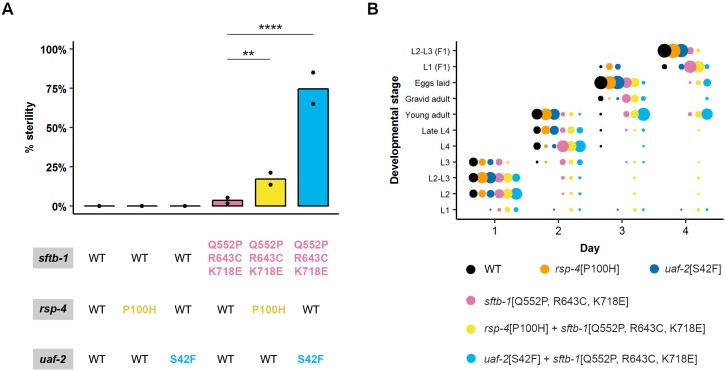
Genetic interaction between rsp-4/SRSF2, uaf-2/U2AF1, and sftb-1 mutant strains.(A) Mean percentage of sterile worms of the indicated genotype at 20°C (N = 2). Black dots denote observed values in each replicate. Statistical significance was determined with the Fisher’s exact test with Bonferroni correction for multiple comparison. Lines indicate compared groups. ** p<0.01, **** p<0.0001. (B) rsp-4[P100H] and uaf-2[S42F] mutations gradually exacerbate the mild developmental delay displayed by the sftb-1[Q552P, R643C, K718E] mutant at 20°C. Dot sizes symbolize the percentage of worms at each developmental stage on any given day. In both panels, n≥110, N = 2.